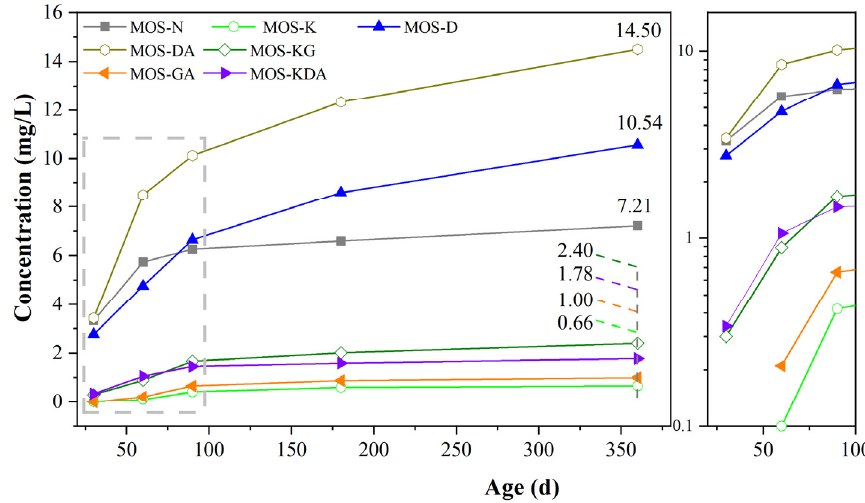
Figure 12. ICP curve for the leaching of boron in magnesium oxysulfate cement-boron mud blends mixed with different modifiers.